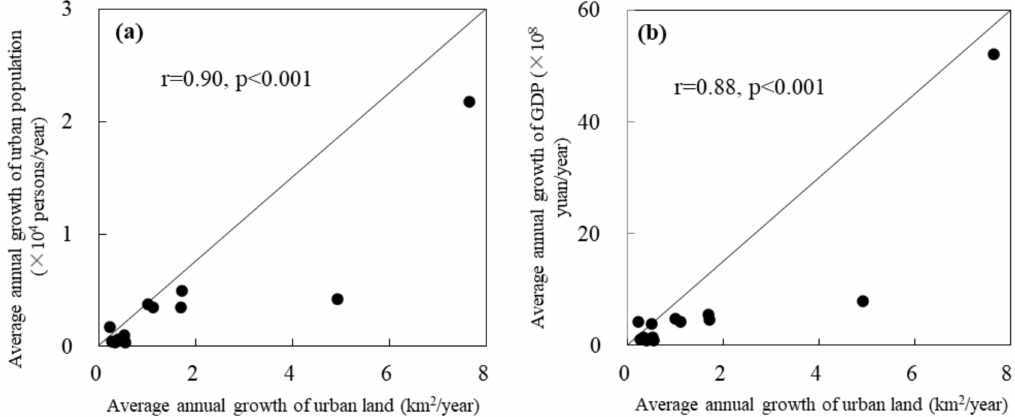
Figure 9. The verification of the quantitative accuracy of urban land data from 2000 to 2010. ( a ) The correlation analysis of urban land and urban population; ( b ) the correlation analysis of urban land and gross domestic product